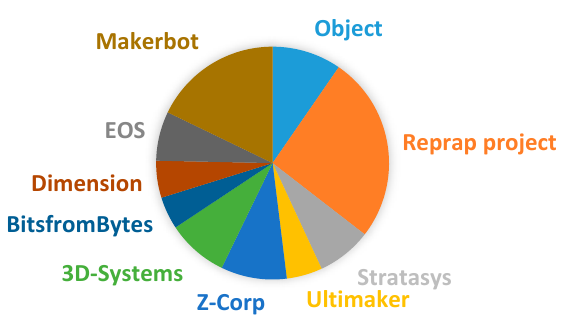
Figure 7. Share of most commonly used 3D printer manufacturers within the 3D printing community (data for chart extracted from reference [45], First Monday, 2013).